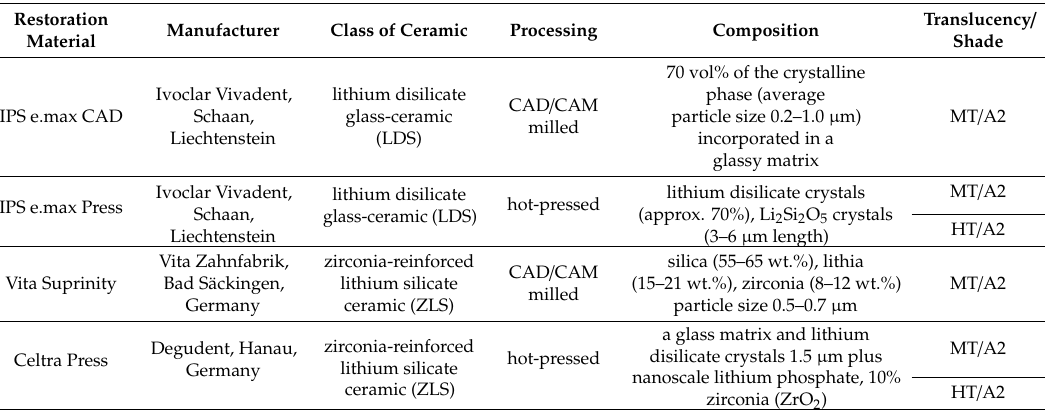
Table 3. Materials involved in the study.